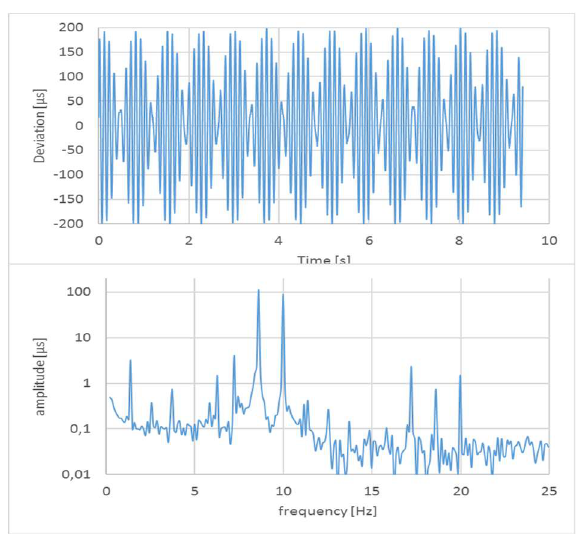
Fig. 3. Top: Deviations of the angular position of the disc from a uniform rotation as indicated by the unique pattern of the fibres inside the GFRP measured while rotating at 600 rpm. Bottom: Corresponding frequency spectrum showing peaks at 10 Hz (rotation frequency) and 8.6 Hz with similar amplitude. Other frequencies (harmonics and mixing frequencies) have amplitudes, which are at least one order of magnitude smaller. The noise level, visible at frequencies above 12 Hz, is below 0.1 µs. The frequency of 8.6 Hz seems to be a consequence of the magnetic forces given by the motor and the moment of inertia of the